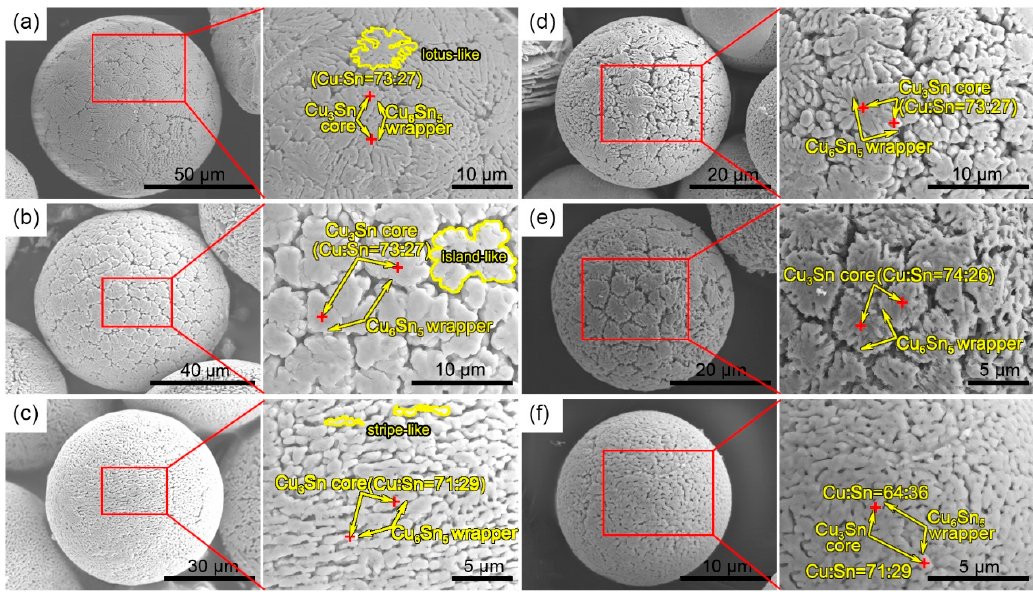
Figure 4. Surface morphology and microstructures of powders with different diameters after being etched with a 10% hydrochloric acid/ethanol solution for 24 h. The powder sizes were ( a ) 84 μ m, ( b ) 72 μ m, ( c ) 59 μ m, ( d ) 44 μ m, ( e ) 36 μ m, and ( f ) 19 μ m. Corresponding enlarged images and compositions are shown to the right.